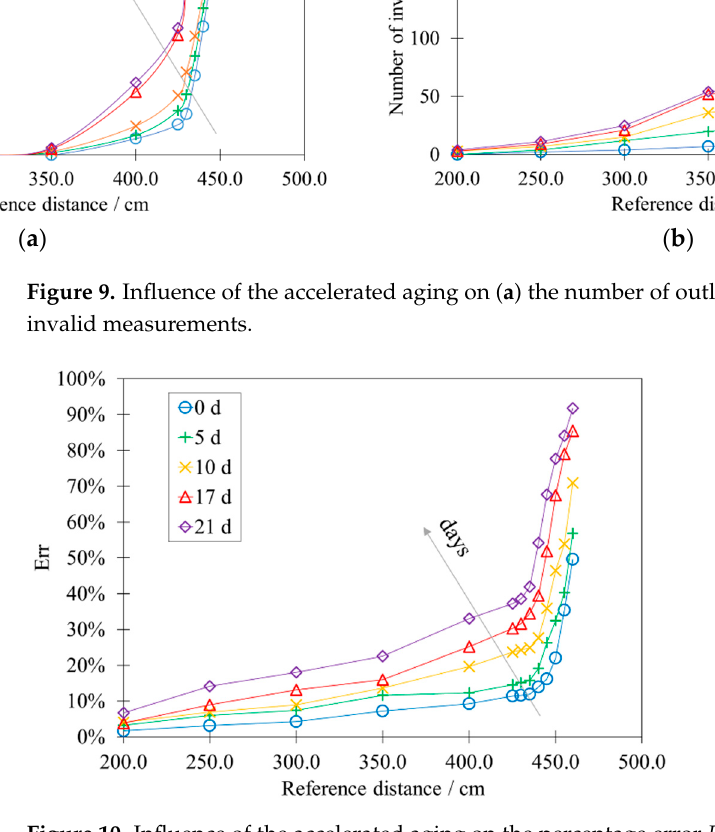
Figure 9. Influence of the accelerated aging on ( a ) the number of outliers and on ( b ) the number of invalid measurements.